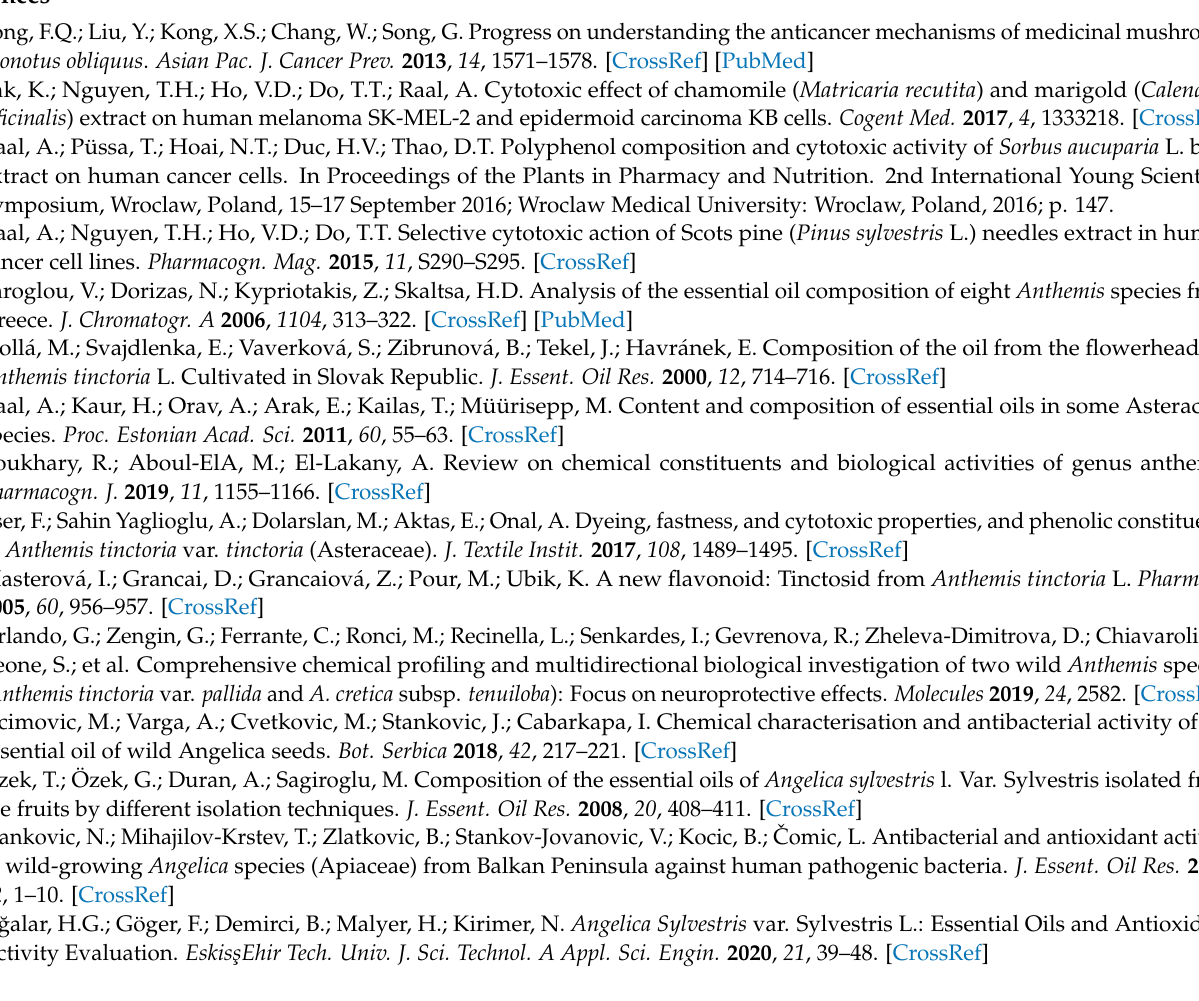
Figure S3: HPLC-chromatograms of roots of Angelica